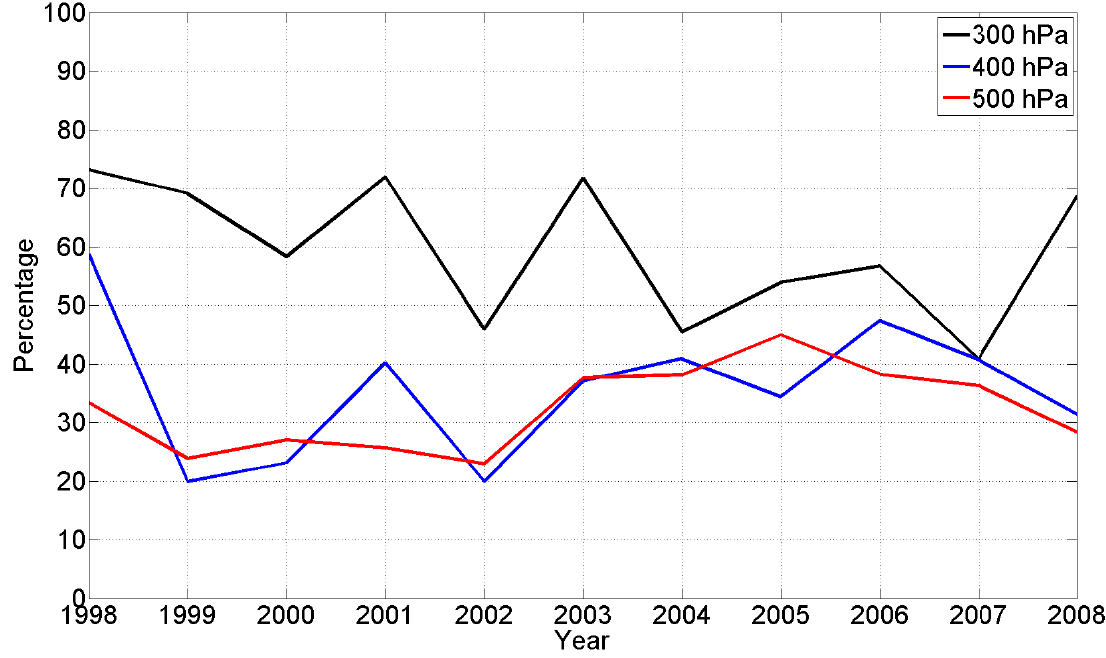
Figure 5. Percentage of trajectories passing above Sahel after leaving India.